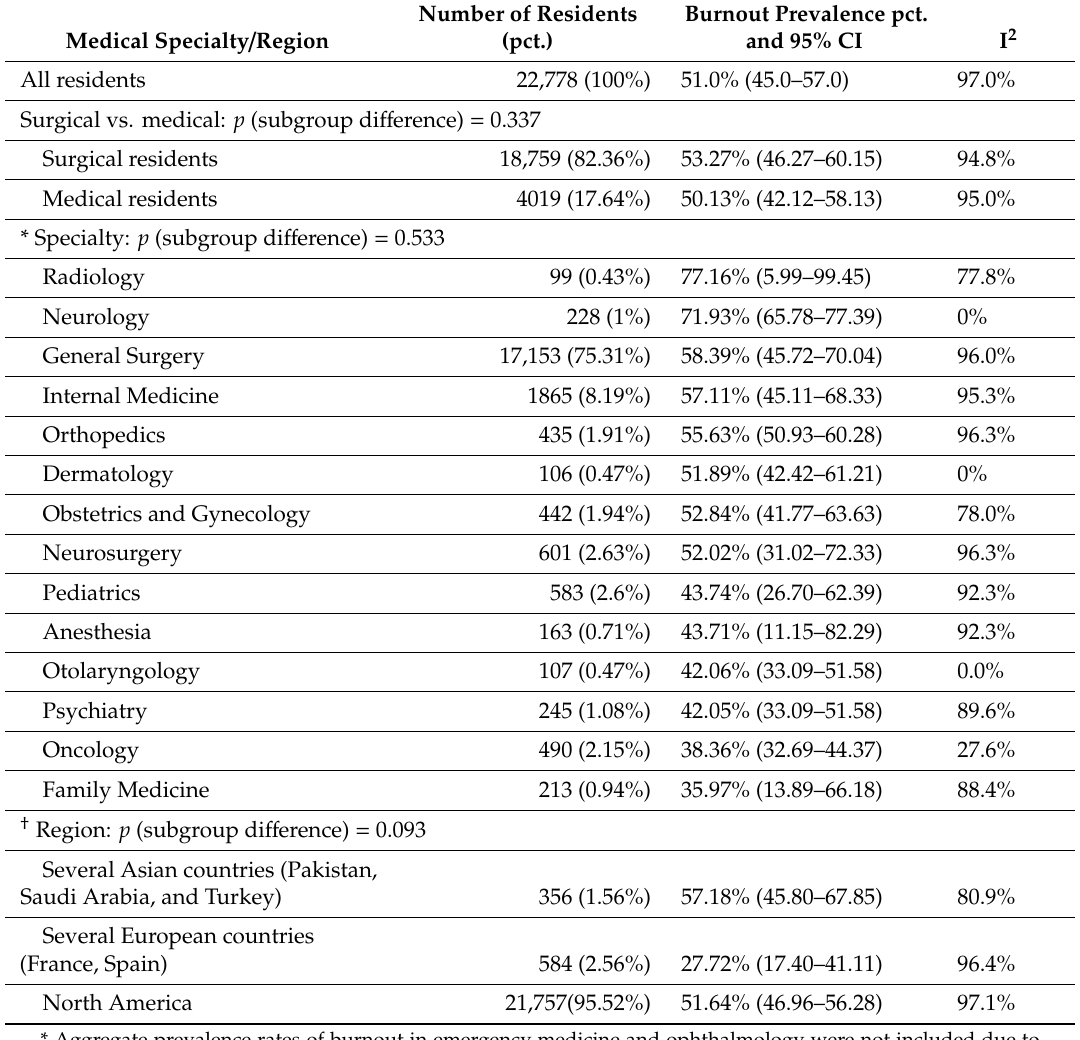
Table 2. Prevalence of burnout in residents by subgroup